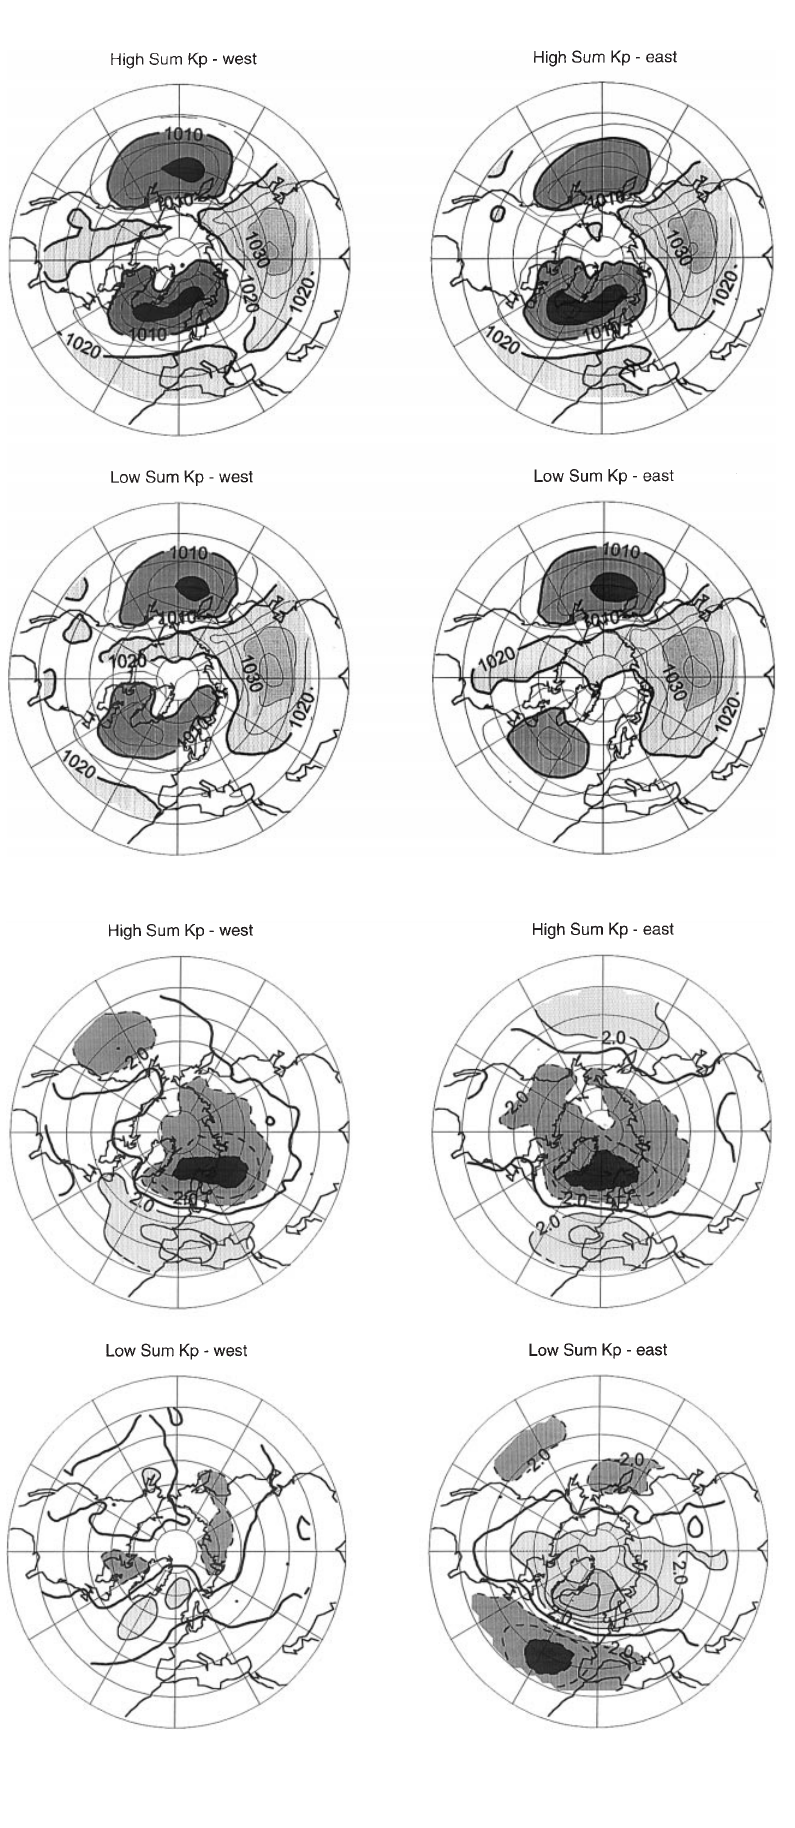
Fig. 2. Distribution of pressure deviations from a long term average (1952–1996) at di(cid:128)erent levels of geomagnetic activity and at di(cid:128)erent QBO- phases (positive, solid lines ; negative, dashed lines ). The intervals between contours are